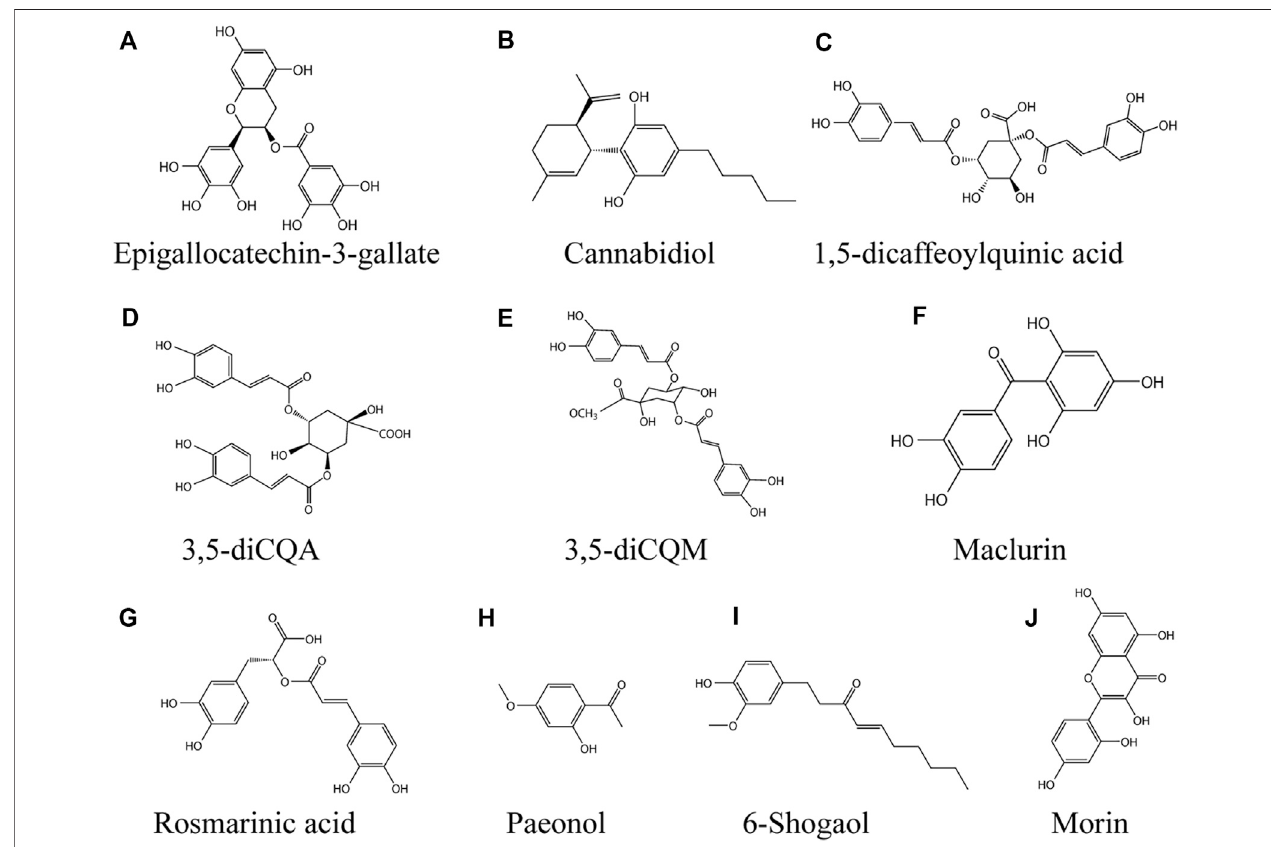
FIGURE 4 | Phenolic compounds against vitiligo (A) EGCG, (B) Cannabidiol, (C) 1,5-dicQA, (D) 3,5-diCQA, (E) 3,5-diCQM, (F) Maclurin, (G) Rosmarinic acid, (H) Paeonol, (I) 6-Shogaol, (J) Morin.